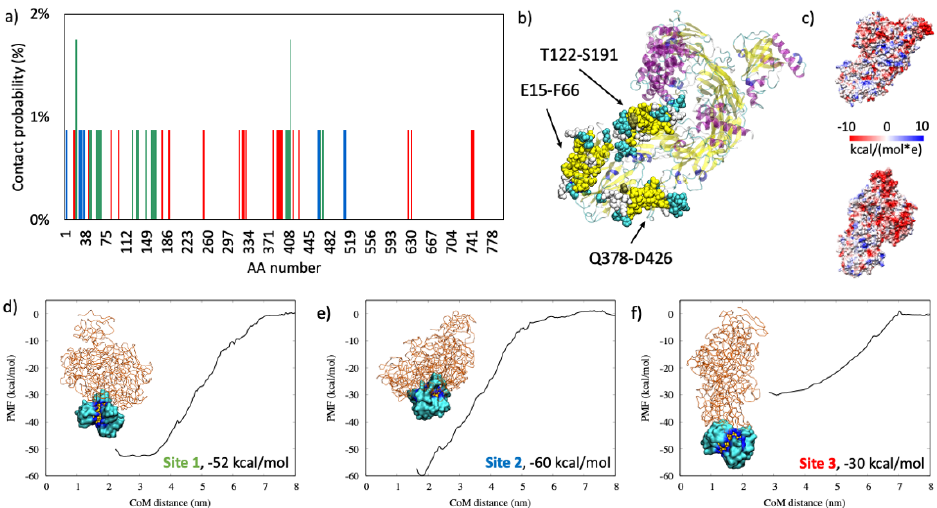
Figure 3. In panel ( a ): the contact probability for each residue upon complement c3 binding to all-MUS AuNP. Each color represents a different binding site. Amino acids over 800 are removed for clarity because their contact probability was zero. In panel ( b ): the graphical representation of the most probable binding sites in VdW, colored accordingly to the protein secondary structure. In panel ( c ): the coulombic surface of complement C3 as viewed from the front (top) and back (bottom). Colors represent the coulombic potential as shown in the legend. In panels ( d – f ): the three binding modalities with the relative PMF curve.